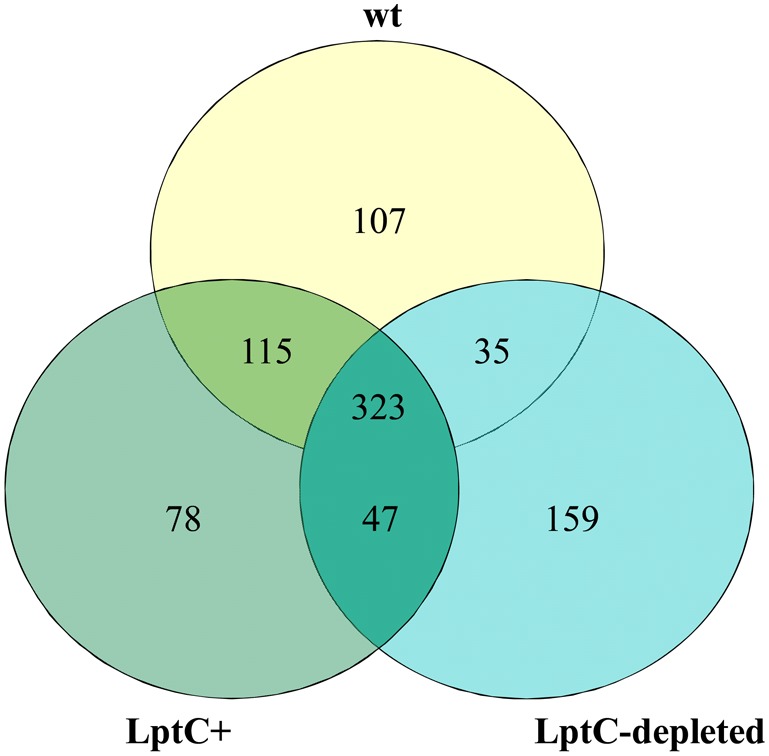
Venn diagram of proteins distribution across strains and growth conditions analysed.Proteins are identified from total membrane samples. wt, (PS201); LptC+ (PS202, araBp-lptC) grown under permissive condition (0,2% arabinose); LptC-depleted, PS202 grown under non permissive condition (without arabinose).